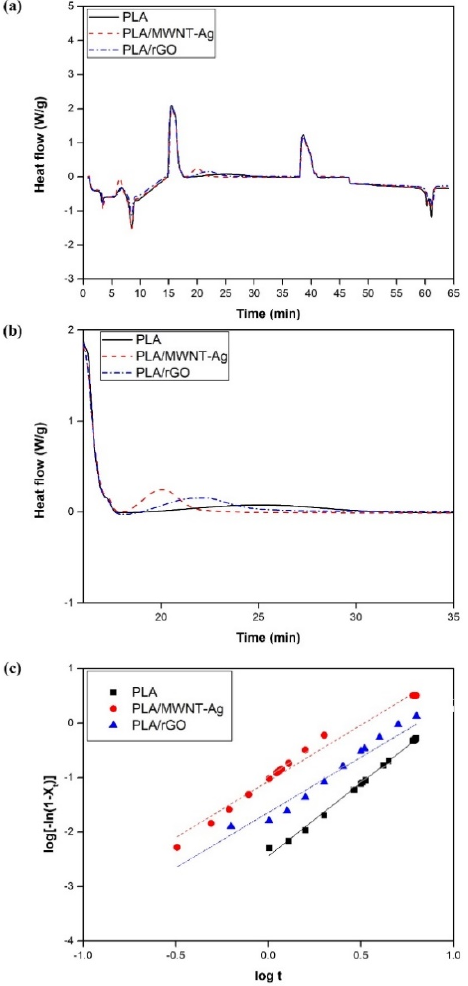
Figure 4. DSC thermograms for samples with different types of nanoparticles: ( a ) results of heating– cooling–heating cycles for the crystallization behavior of PLA-based films; ( b ) isothermal DSC ther- mograms at 110 ℃ ; and ( c ) plots of log [ln(1 ₋ X t )] versus log t for the PLA-based films at 110 ℃ . Table 3. Thermal characteristic parameters of PLA-based films, obtained from DSC.